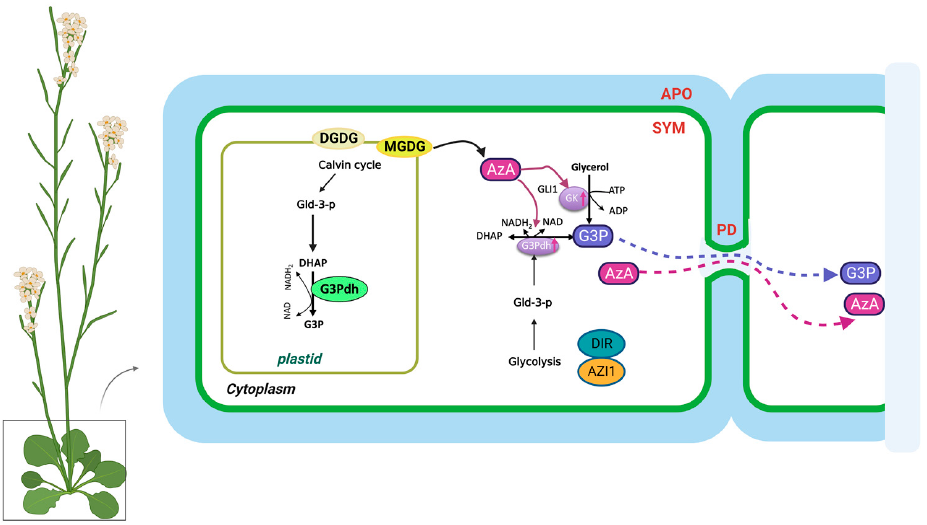
Figure 2. The biosynthesis and transport of azelaic acid and glycerol-3-phosphate in the plant cell. AzA and G3P are transported via the symplast through plasmodesmata (PD). AZA induces G3P biosynthesis through its effects on genes involved in SAR. DIR1 and AZI1, both of which depend on G3P for stability, are required for G3P-mediated SAR signaling. G3P is either converted to glycerol by G3P phosphatase or used to synthesize membrane lipids (glycerolipids) and triacylglycerol (TAG). The source of DHAP is glyceraldehyde-3-phosphate (Gld-3-P), which originates from glycolysis and the Calvin cycle. DGDG, galactolipid digalactosyldiacylglycerol; MGDG, monogalatosyldia- cylglycerol; AzA, azelaic acid; G3P, glycerol-3-phosphate; Gld-3-P, Glyceraldehyde-3-Phosphate; DHAP, DHA phosphate; GK, glycerol kinase; G3Pdh, G3P dehydrogenase; DIR1, Defective Induced Resistance 1; AZI1, AzA Insensitive 1 (AZI1).